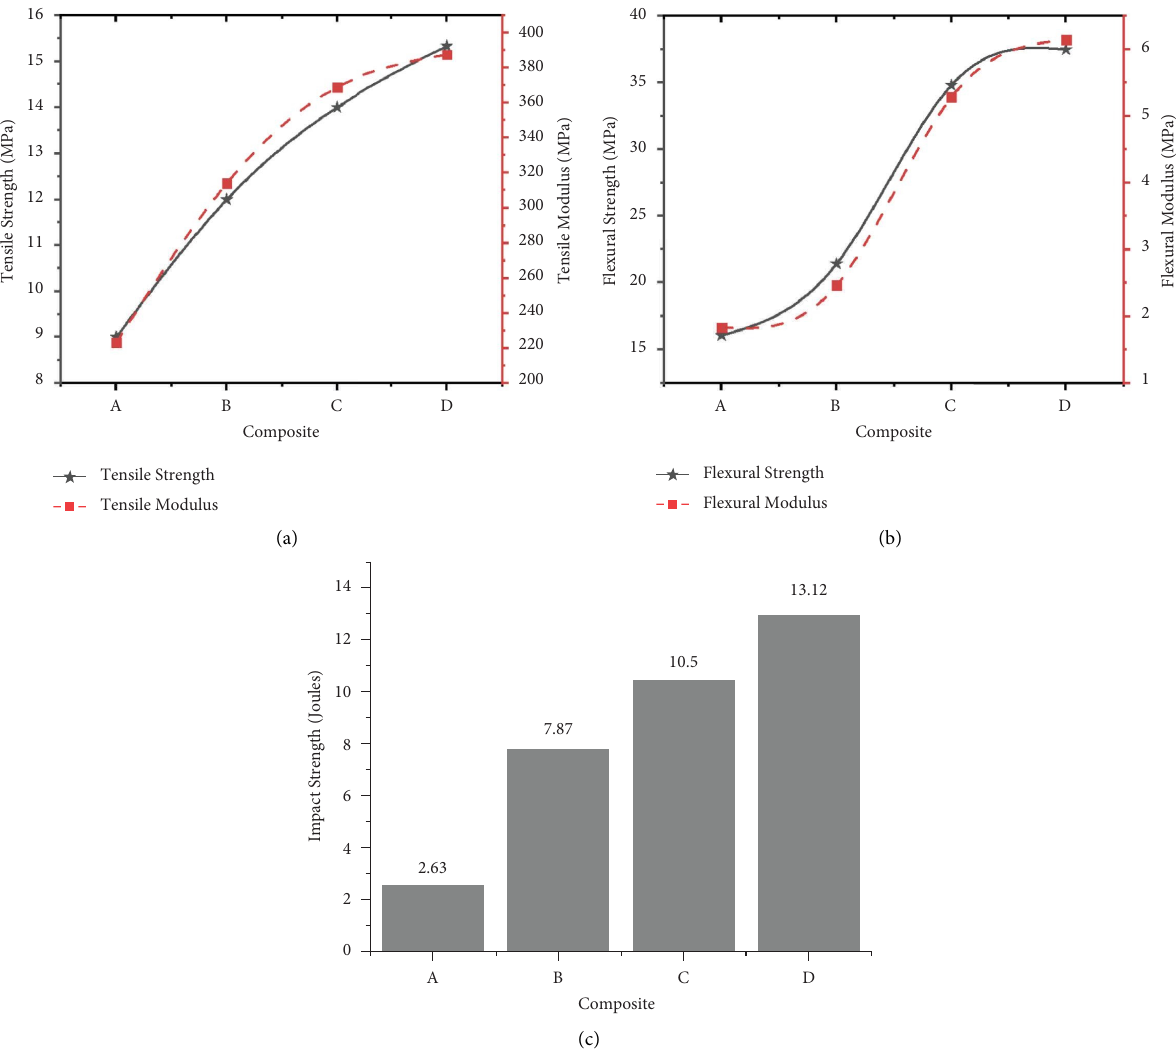
Figure 3: Mechanical properties of hybrid composite.